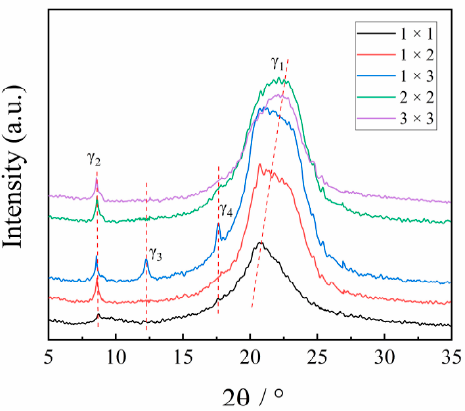
Figure 3. The 1D-WAXS patterns of PA510/SiO 2 films at various stretching ratios in the surface.